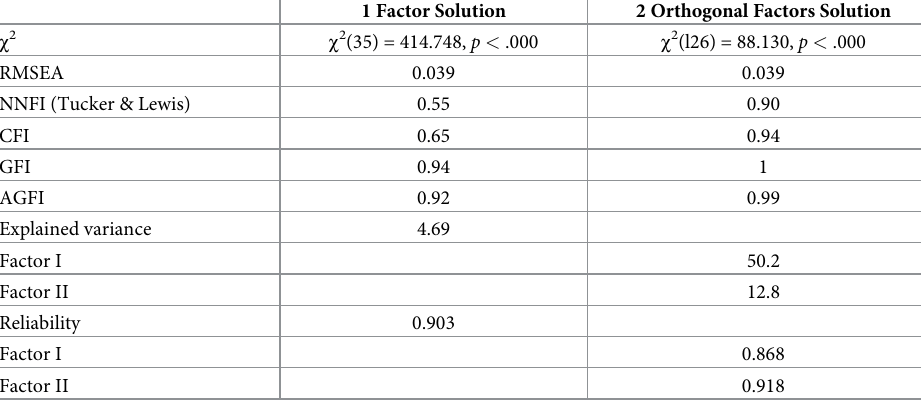
Table 3. One-dimensional solution, two oblique factors and two orthogonal factors.